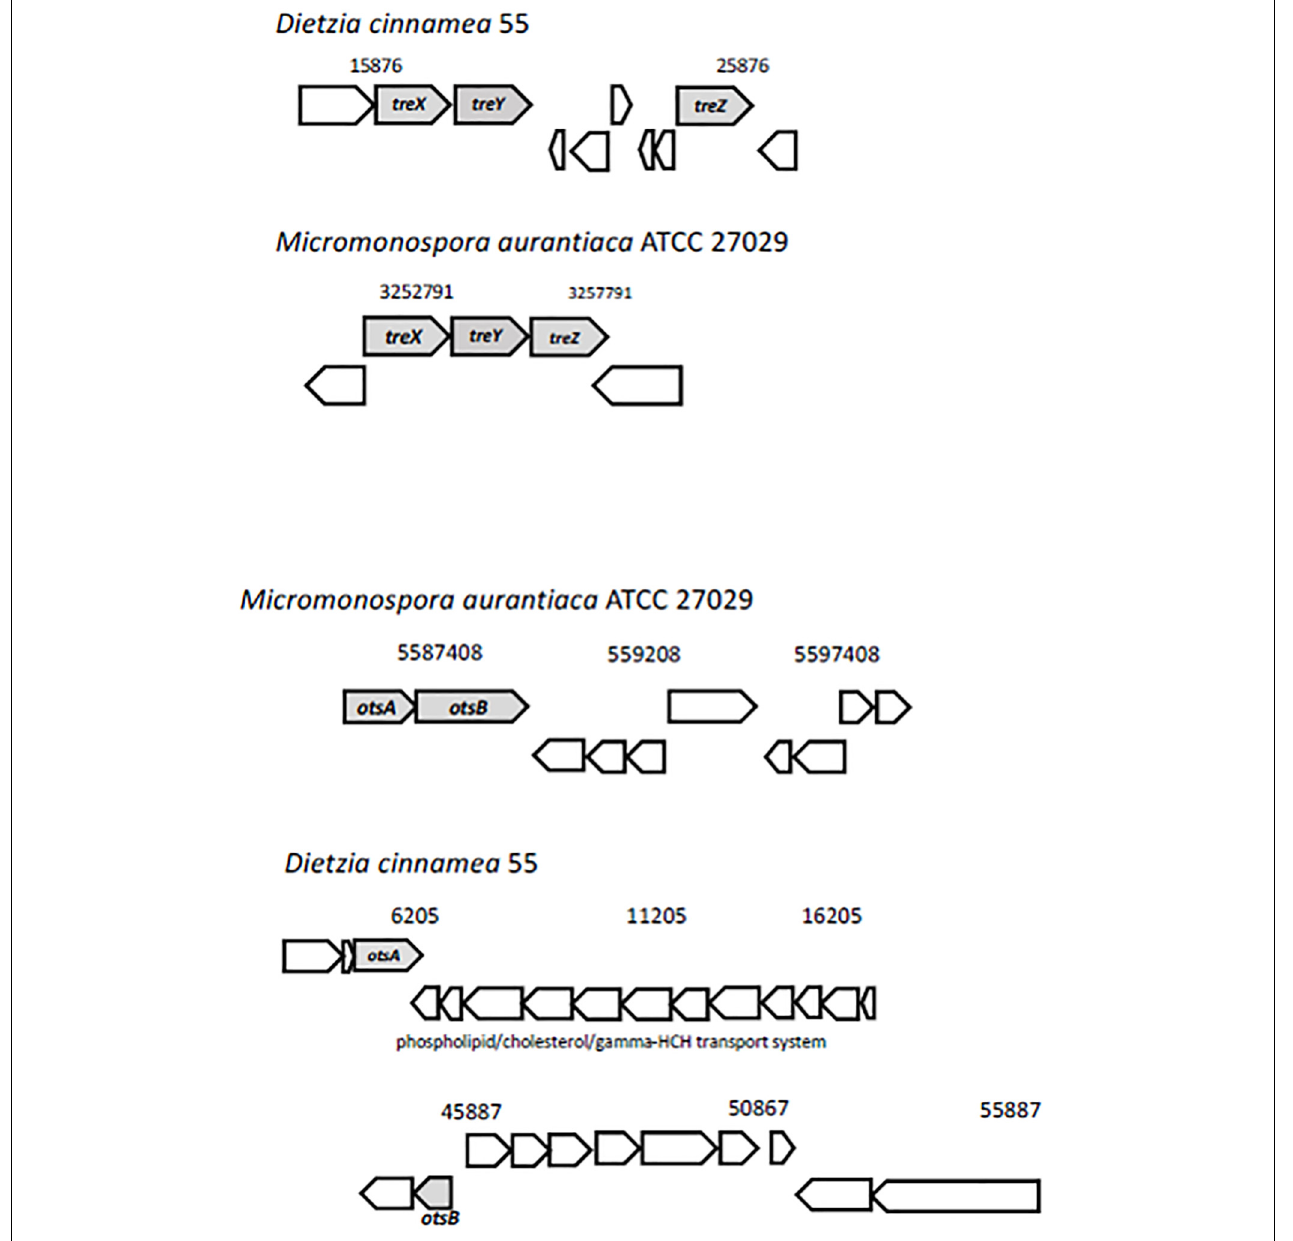
FIGURE 5 | Possible mechanisms of stress tolerance via trehalose accumulation in D. cinnamea 55. The treXYZ genes in D. cinnamea 55 and M. aurantiaca ATCC 27029, MOTS pathway. The otsA and otsB are together in an operon for M. aurantiaca ATCC 27029 whereas in D. cinnamea 55, they are in two separate contigs, TPS pathway. The phospholipid/cholesterol/gamma-HCH transport gene system is shown for